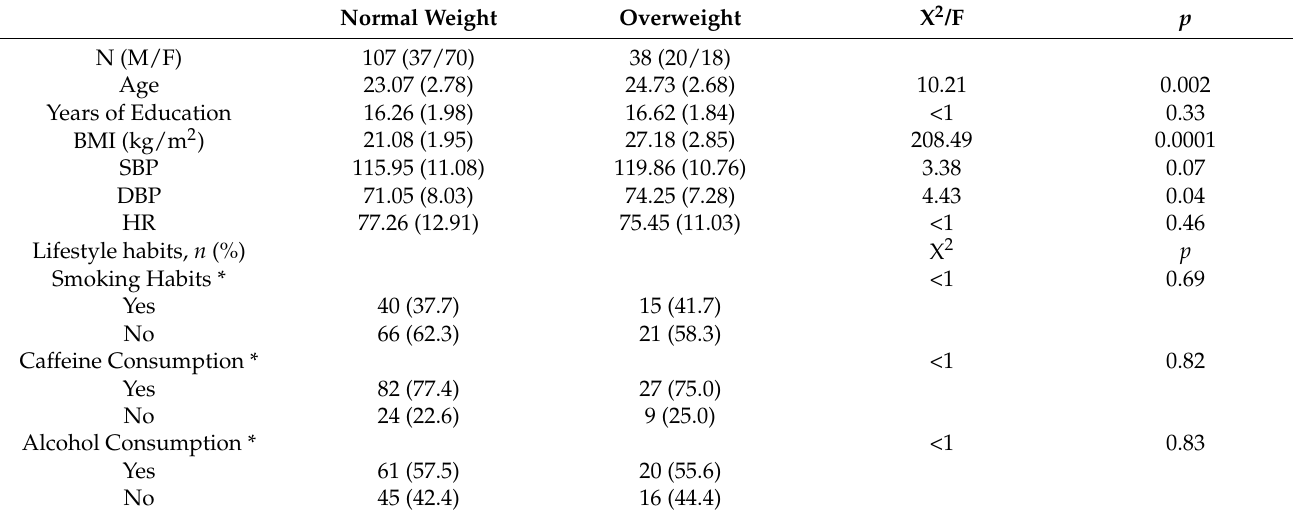
Table 1. Characteristics of normal-weight and overweight